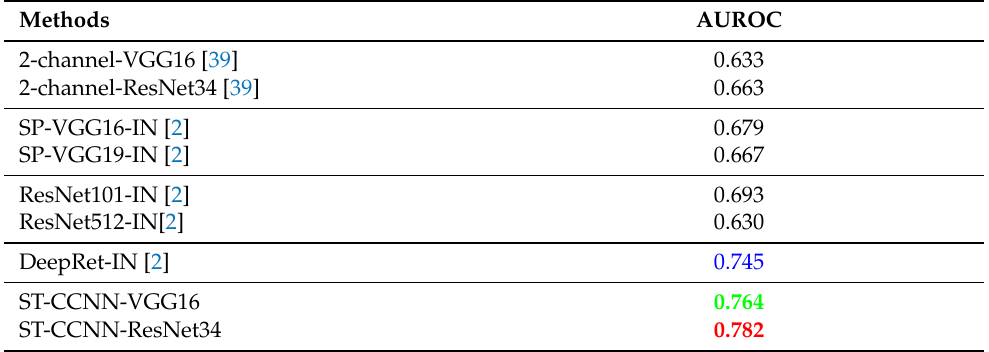
Table 3. AUROC comparison on cross-modality dataset TNO of ST-CCNN and other state-of-the-art methods.